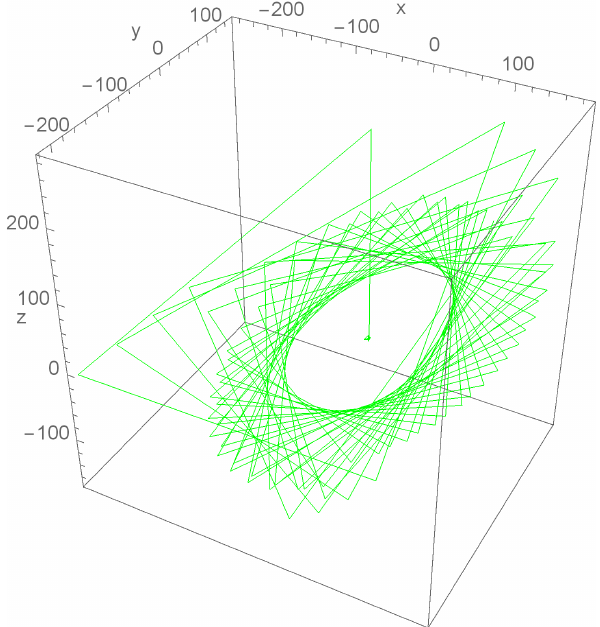
Figure 25. Combined Graph of behavior of solution of x n (shown in red line) y n (shown in blue line) and z n (shown in black line) for α = 0.00001, β = 2.0, γ = 3.0, δ = 4.0, ζ = 0.00005, η = 6.0, µ = 7.0, ε = 0.00009, υ = 8.0, ρ = 10.0, σ = 11.0, ω = 12.0. with initial conditions x 0 = 1.0, y 0 = 2.0 and z 0 = 3.0.